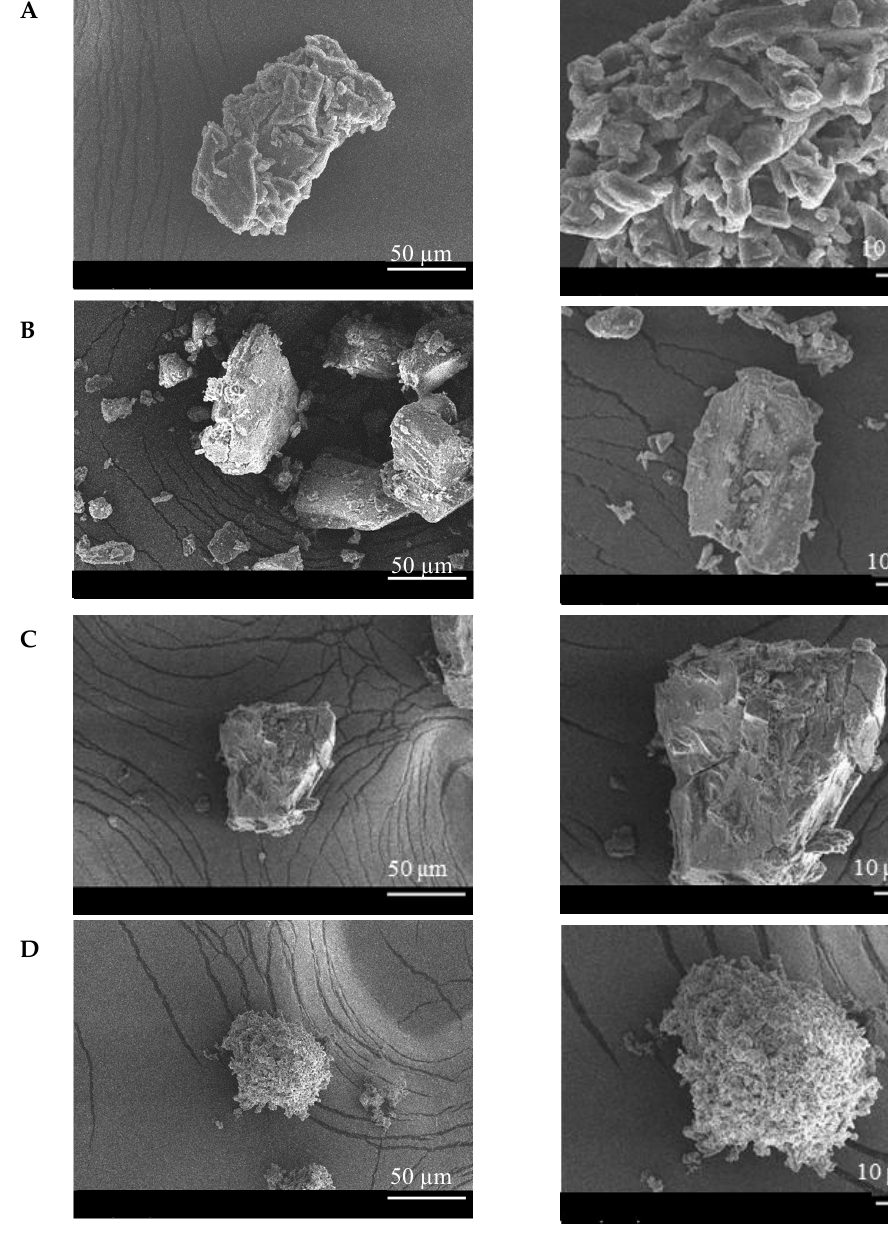
Figure 5. Scanning electron microscopy micrographs of isopentyl caffeate (ICaf) ( A ), β -cyclodextrin ( β -CD) ( B ) and inclusion complex (ICaf: β -CD) prepared by physical mixture (PM) ( C ) and co-evaporation (CO) ( D ) using 1:1 molar ratios. Left: ×500 magnification, right: ×1000 magnification.